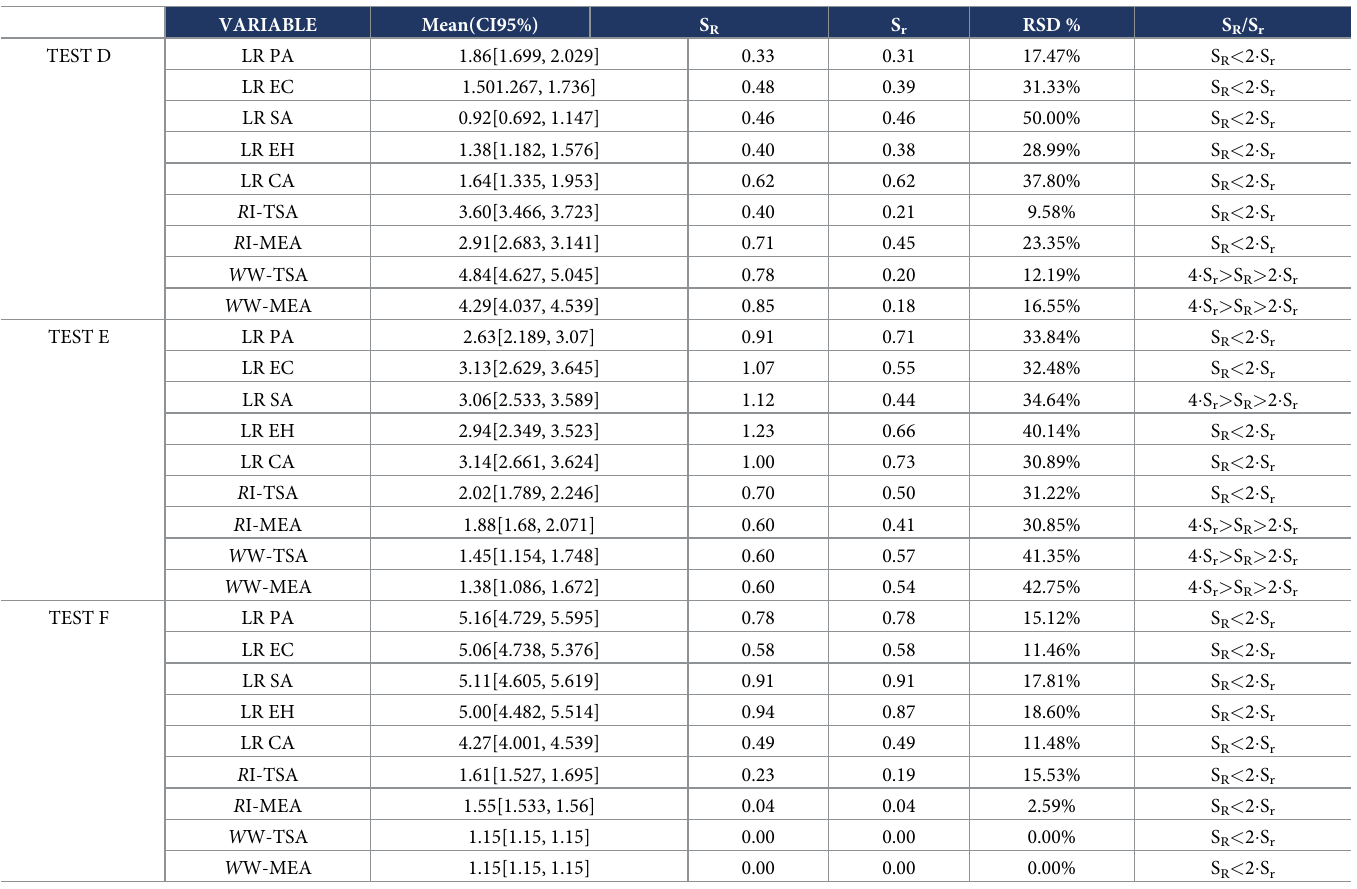
Table 2. Precision statistics for testing per prEN17658 in the rinse cycle